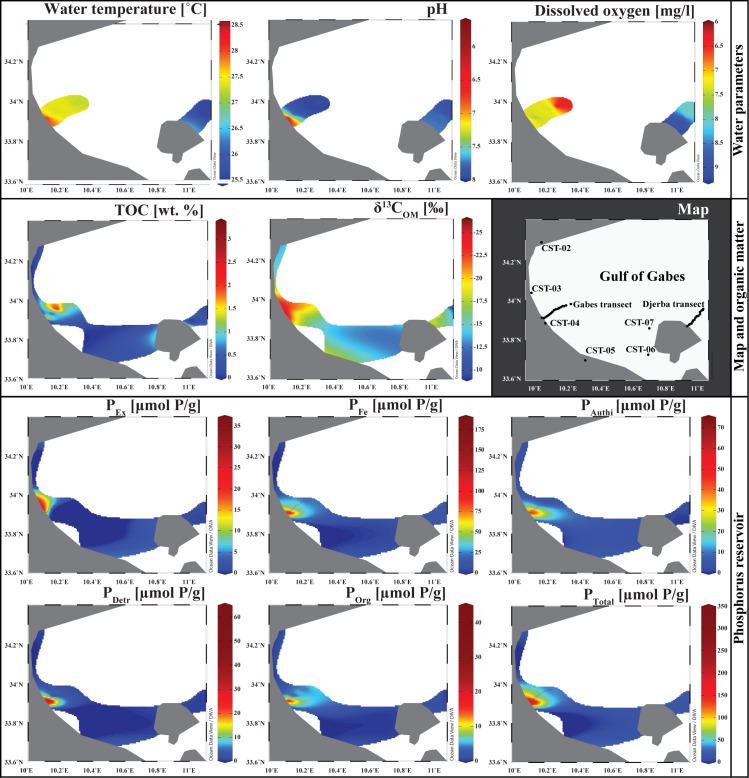
Isosurface in the Gulf of Gabes.Water parameters, TOC, carbon isotope composition of sedimentary organic matter, phosphorus reservoir concentrations are plot on a 2D Maps of the Gulf of Gabes. The maps are drawn by using the Ocean Data View software [47].